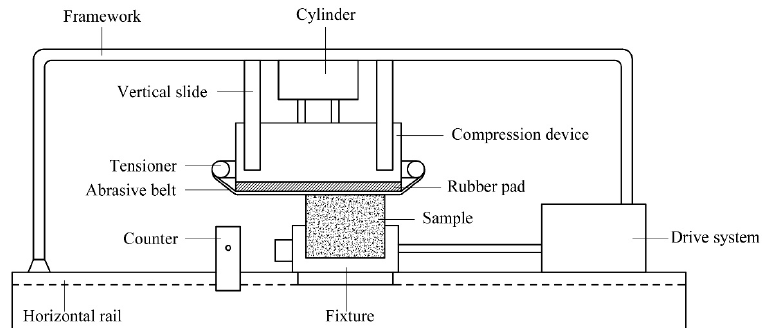
Figure 1. Schematic diagram of abrasive-belt sanding device.